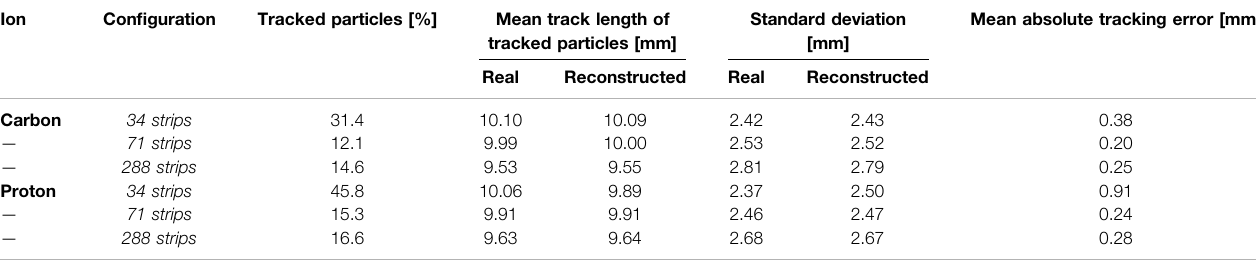
TABLE1| PercentageofparticlestrackedbyHDM,includingtheirmeantracklength,standarddeviationsandtheabsolutevaluesofthemeantrackingerrorofthealgorithm with respect to the actual value. The results are reported for both protons and carbon ions and for three LGAD con fi gurations (34, 71 and 288 strips). Ion